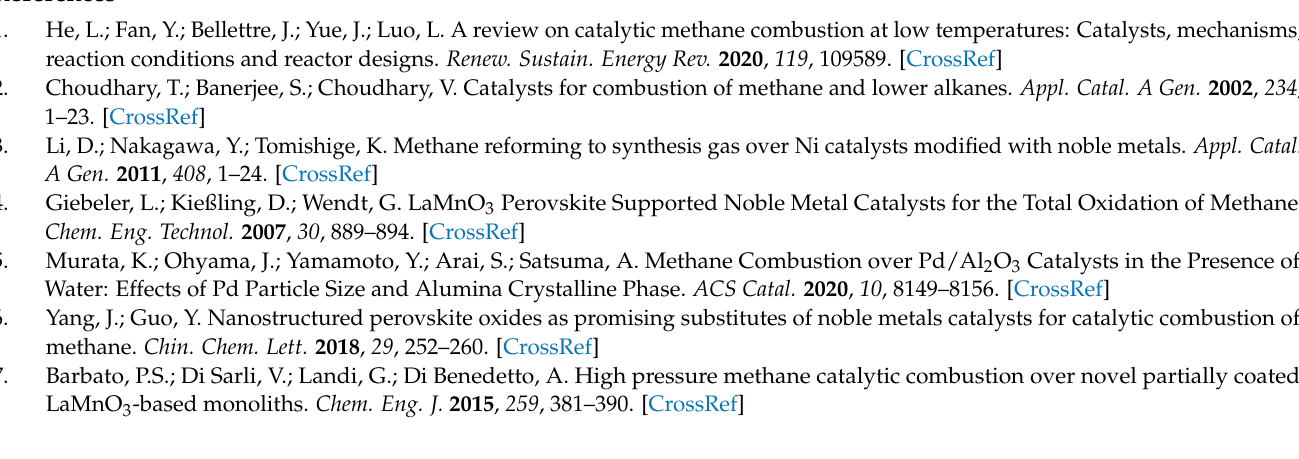
He atmosphere; Figure S2: HRTEM image of the sample after the reaction. White arrows show planar vacancies. Co 3 O 4 particles are shown by white circle; Equations (S1) and (S2): The chemical equations of decomposition process in CH 4 and He; Equations (S3) and (S4): The quasichemical equations of vacancies